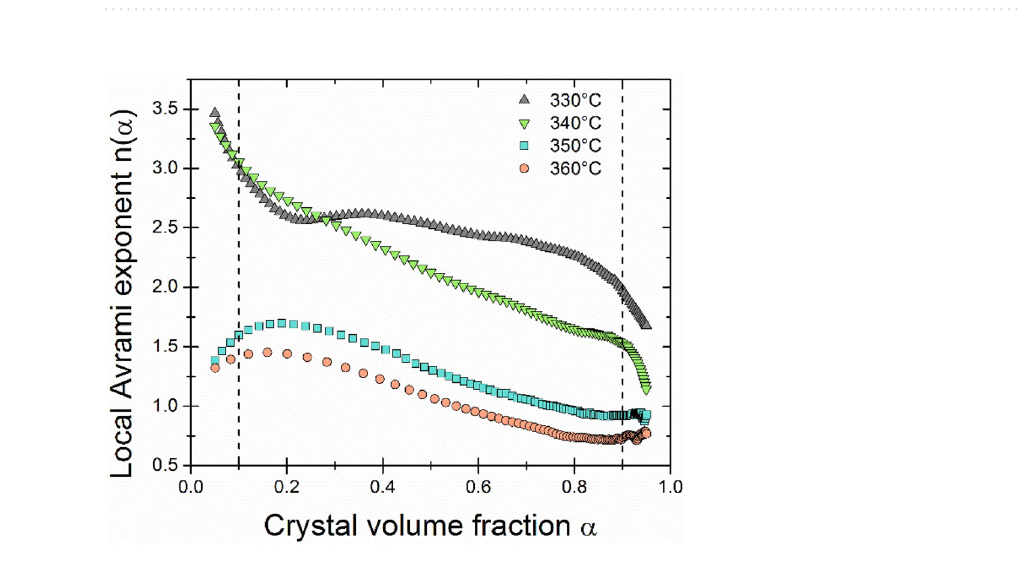
Figure 1. Isothermal kinetics results: ( a ) heat flows; ( b ) Avrami plot with calculated kinetic parameters n and k.